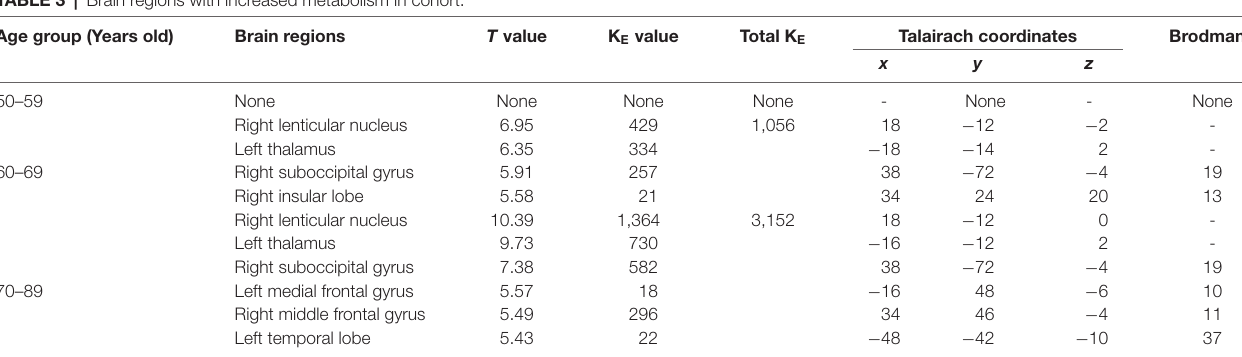
TABLE 3 | Brain regions with increased metabolism in cohort.